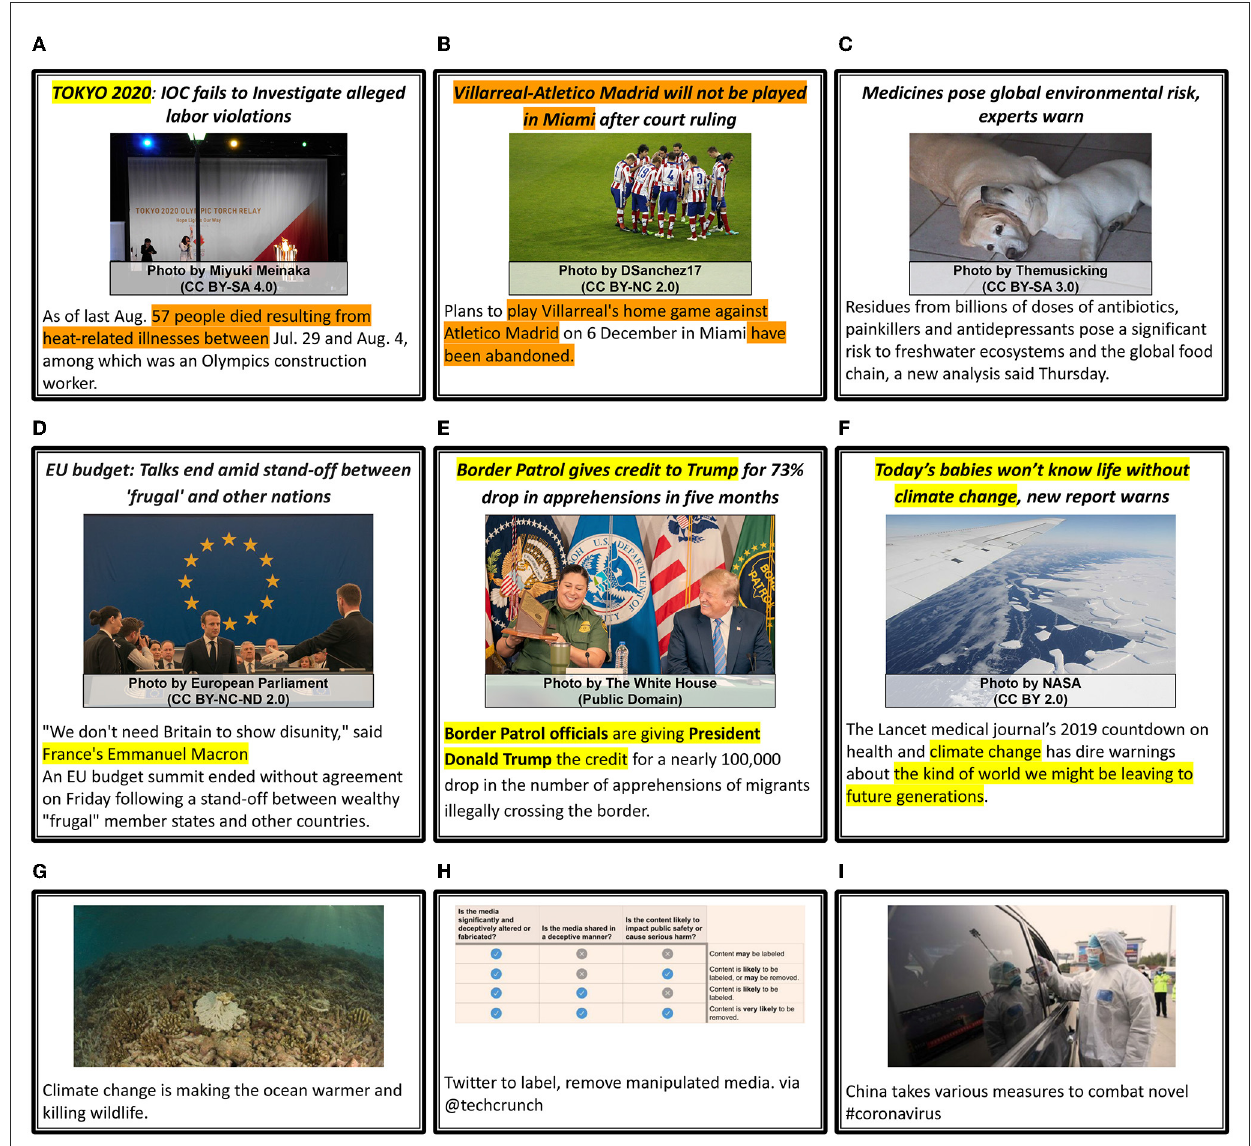
FIGURE7 Semantic Correlation (SC) and STATUS examples. Negative correlation examples have highlighted portion in text (orange) that is opposite in meaning to the image. Low and high-positive correlation examples have highlighted portion in text (yellow) that is aligned in meaning to the image. (A) SC: Negative correlation. (B) SC: Negative correlation. (C) SC: Zero correlation. (D) SC: Low-positive correlation. (E) SC: High-positive correlation. (F) SC: High positive correlation. (G) STATUS: Equal. (H) STATUS: Image. (I) STATUS: